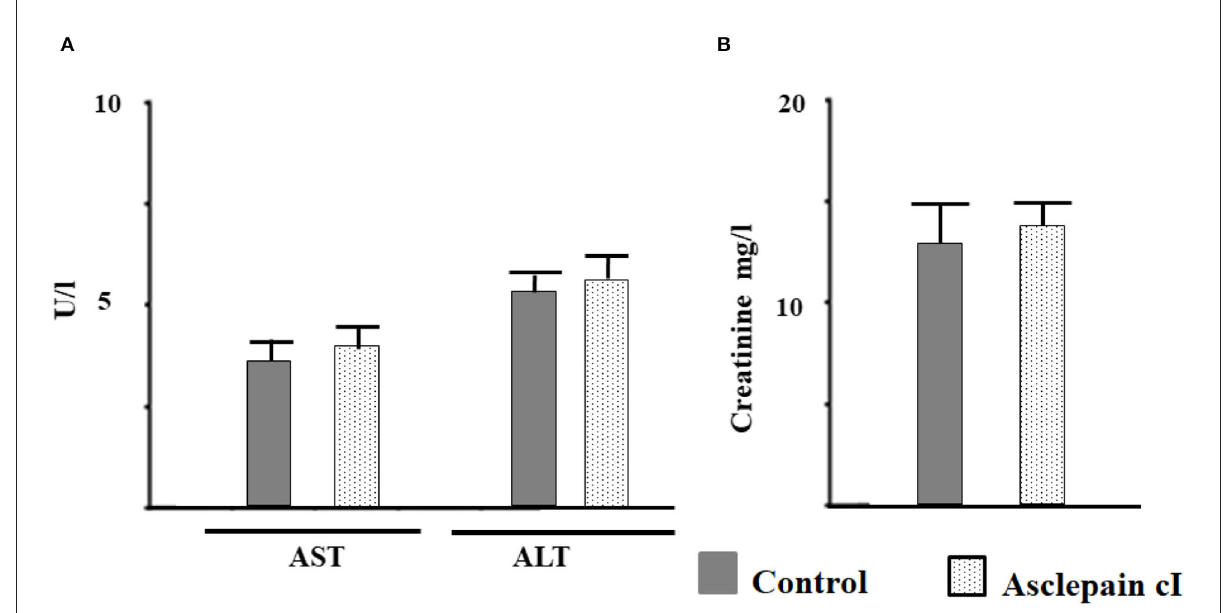
FIGURE5 Toxicological effect of asclepain cI evaluated as: (A) The activity of aspartate aminotransferase (AST), alanine aminotransferase (ALT); (B) creatinine in